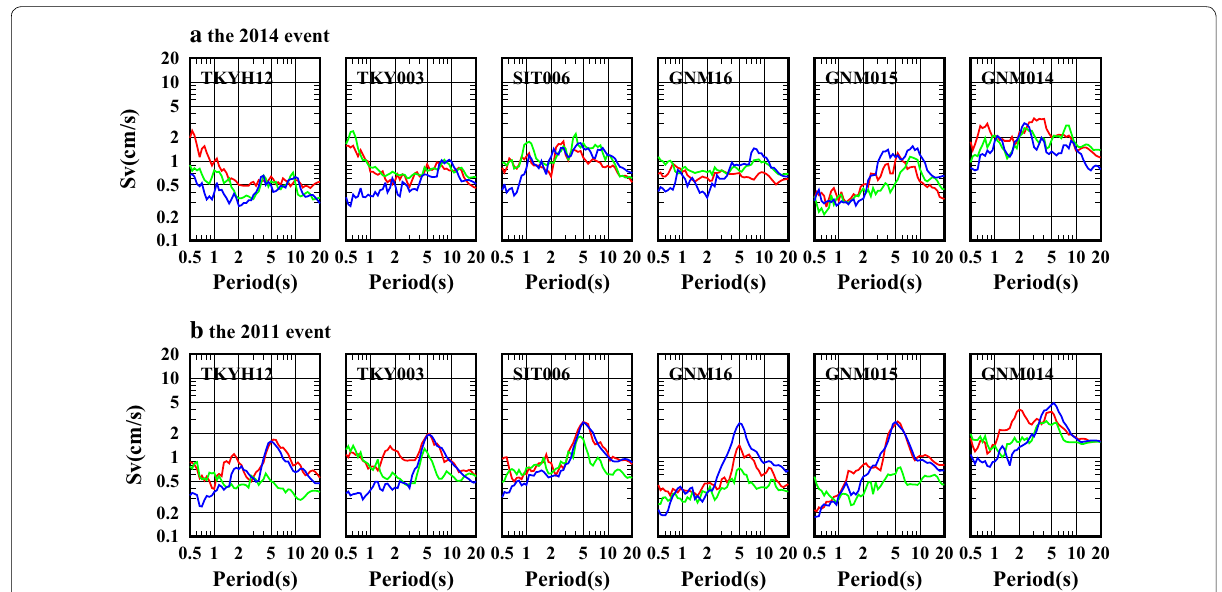
Fig. 7 Velocity response spectra at stations located in the outside the basin area. b Show the 2011 event spectra; a show those of the 2014 event. Red , green , and blue lines indicate the spectra of the NS, EW, and UD components, respectively. Characters in each frame indicate the station code. The location of each station is shown in Fig.